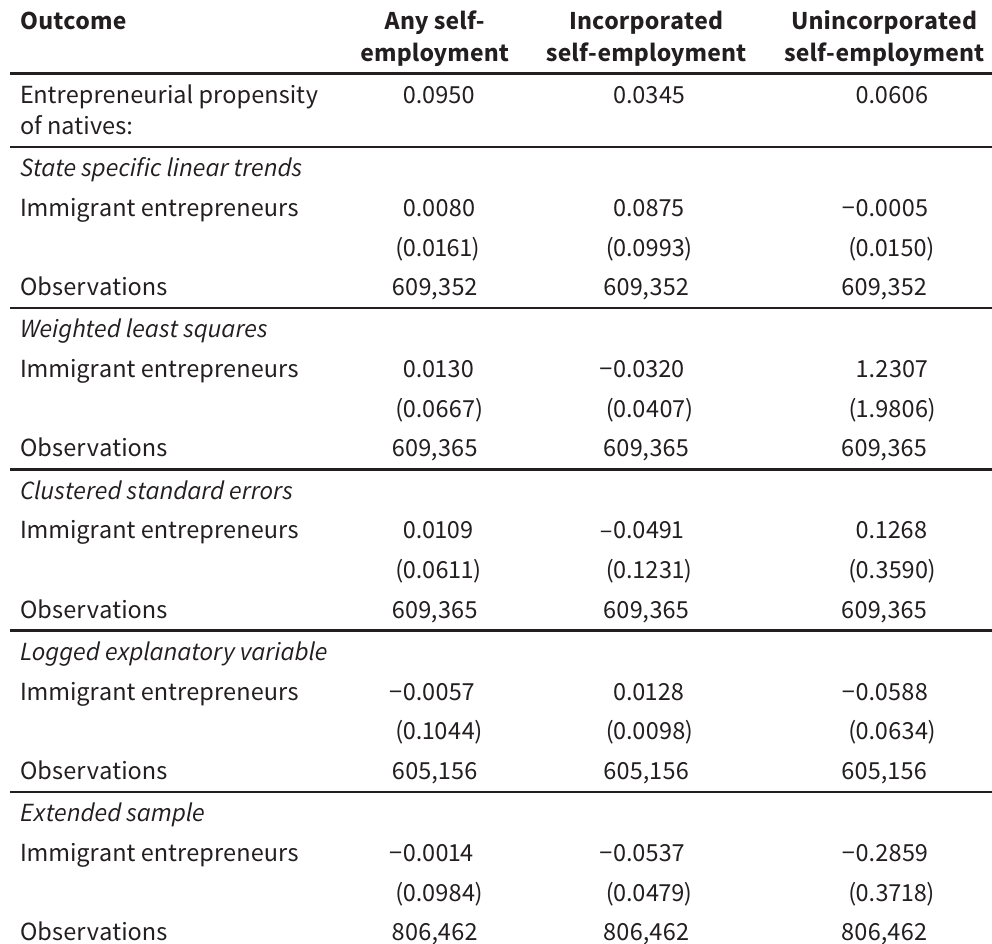
Table 6 Sensitivity to modeling and sampling choices: TSLS estimates Outcome Any self-